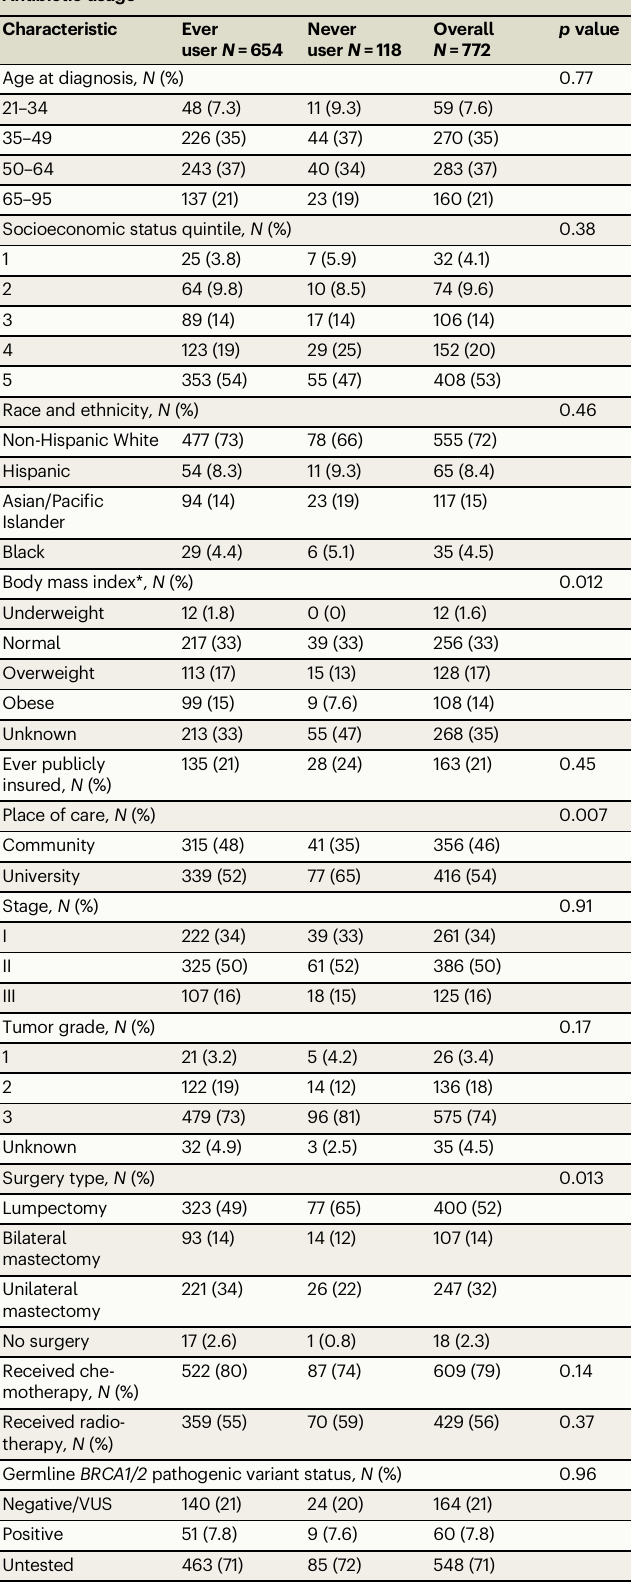
Table 1 | Baseline sociodemographic and clinical character- istics of triple-negative breast cancer patients by antibiotic use after